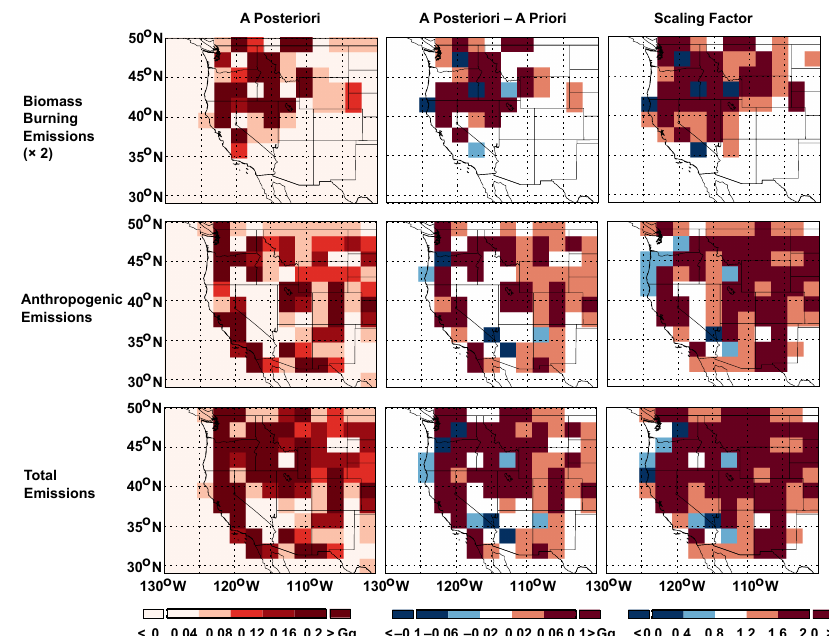
Figure 4. Emissions of BC in the WUS for August 2006: (top panels) biomass burning, (middle panels) anthropogenic, and (bottom panels) total emissions. Results are from Case 6 (Table 1): (left column) the optimized inventory, (middle column) a posteriori–a priori, and (right column) the scaling factors. Case 6 is same as Case 1, except with only 56 sites used in the inversion. For the purpose of clarity, biomass burning emissions are multiplied by 2 in the figures.